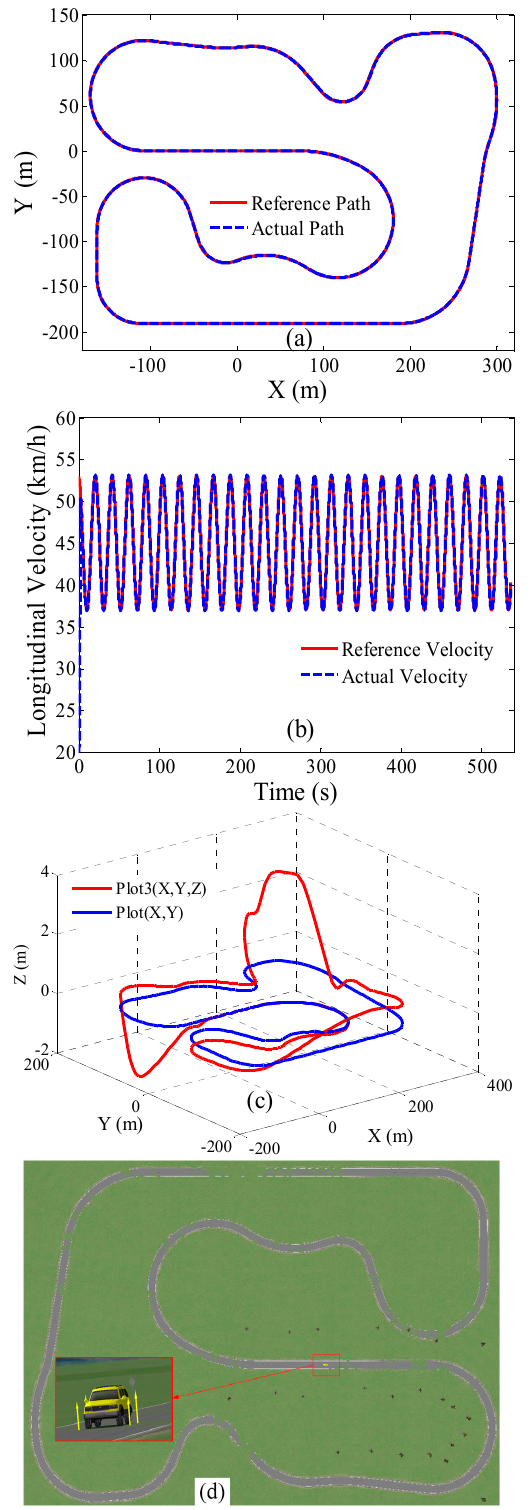
Figure 11. The tracking results of the ring-road test: ( a ) path tracking projection in X-Y plane; ( b ) speed following result; ( c ) 3D profile of the ring-road; ( d ) airview map of the ring-road.